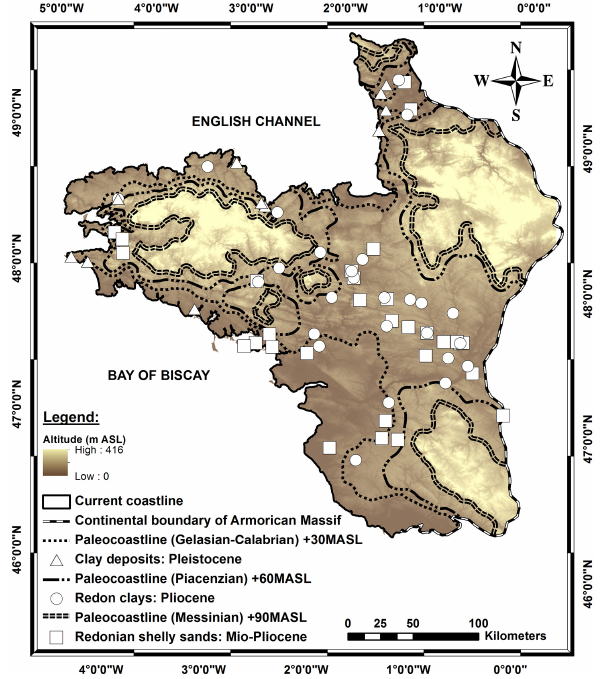
Figure 3. Localization of paleocoastlines on the current topogra- phy for past marine transgressions since the Mio-Pliocene time and characteristic sediments associated with each flooding period.